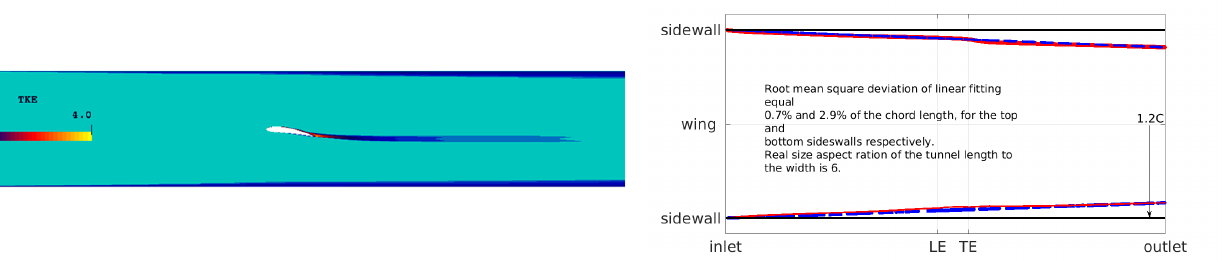
Figure 9. Boundary-layer edge with the presence of the airfoil at AOA = 8 ◦ according to turbulent kinetic energy; left : TKE contour within the specified range [m/s] 2 , right : Contour line of TKE (red) and the linear fit to that (blue).